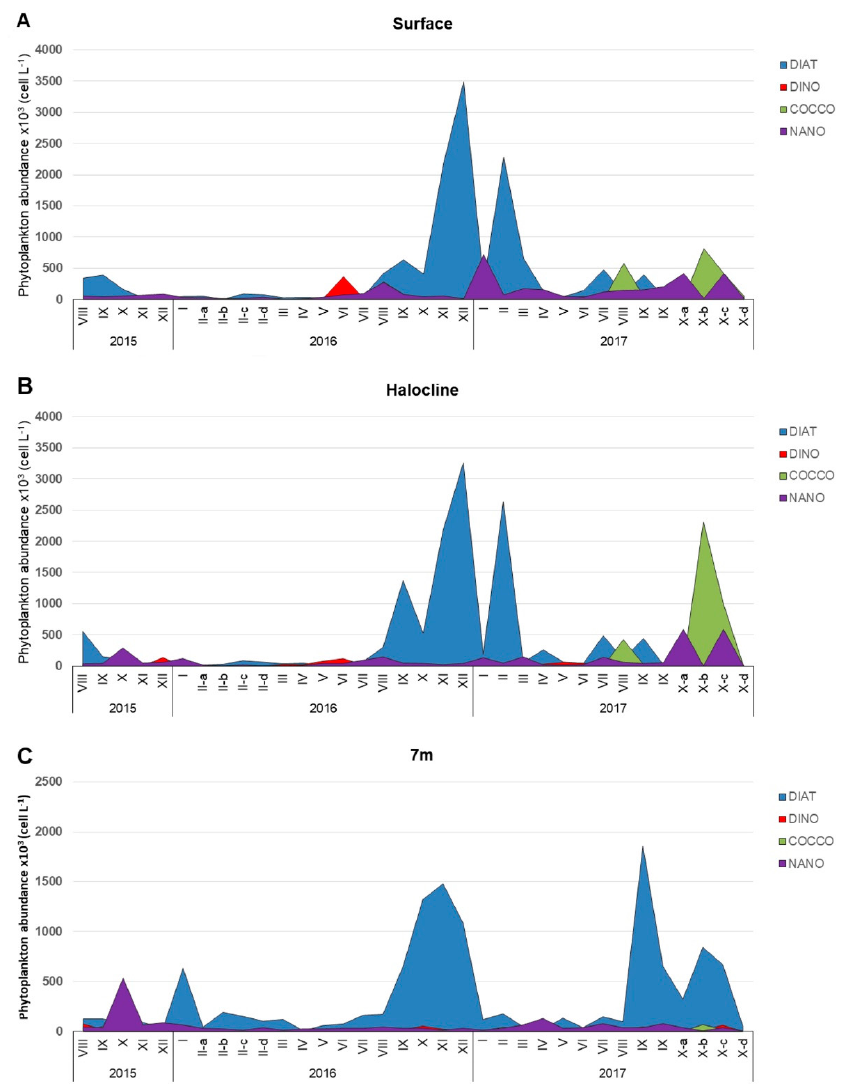
Figure 2. The abundance of main phytoplankton groups: diatoms (DIAT), dinoflagellates (DINO), coccolithophores (COCCO) and nanoflagellates (NANO) at the ( A ) surface, ( B ) halocline, and ( C ) 7 m depth.